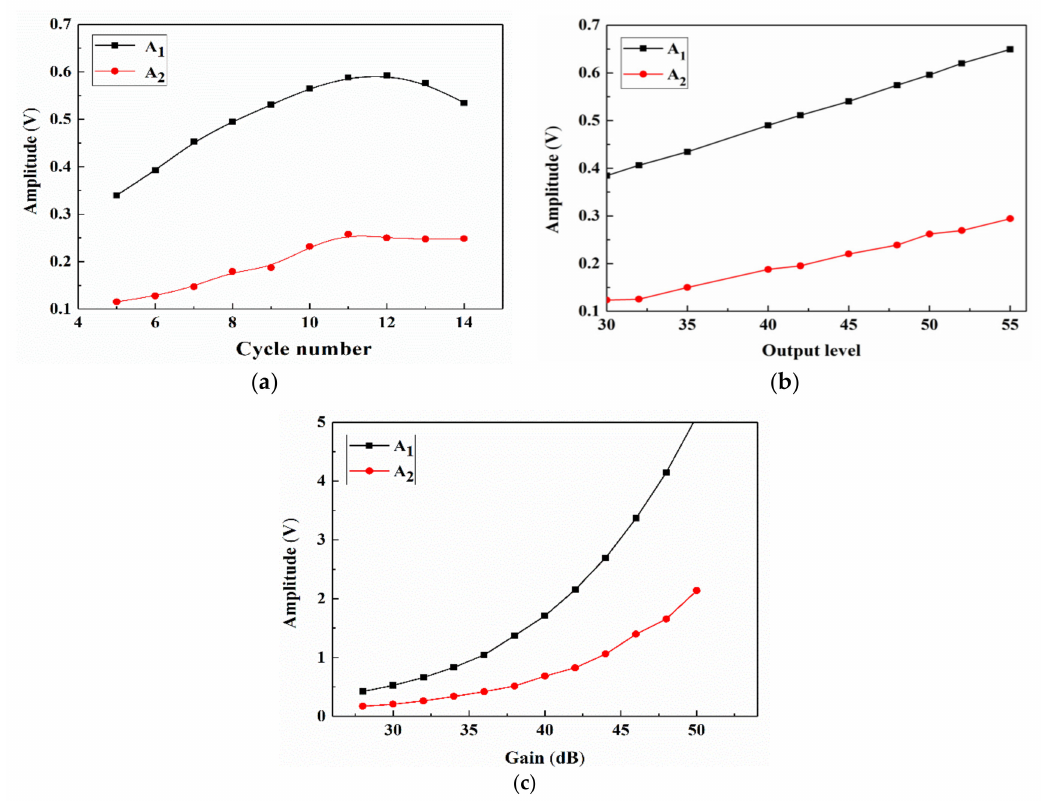
Figure 5. Single-factor experimental effect of the ( a ) cycle number, ( b ) output level, and ( c ) gain on A 1 and A 2 .